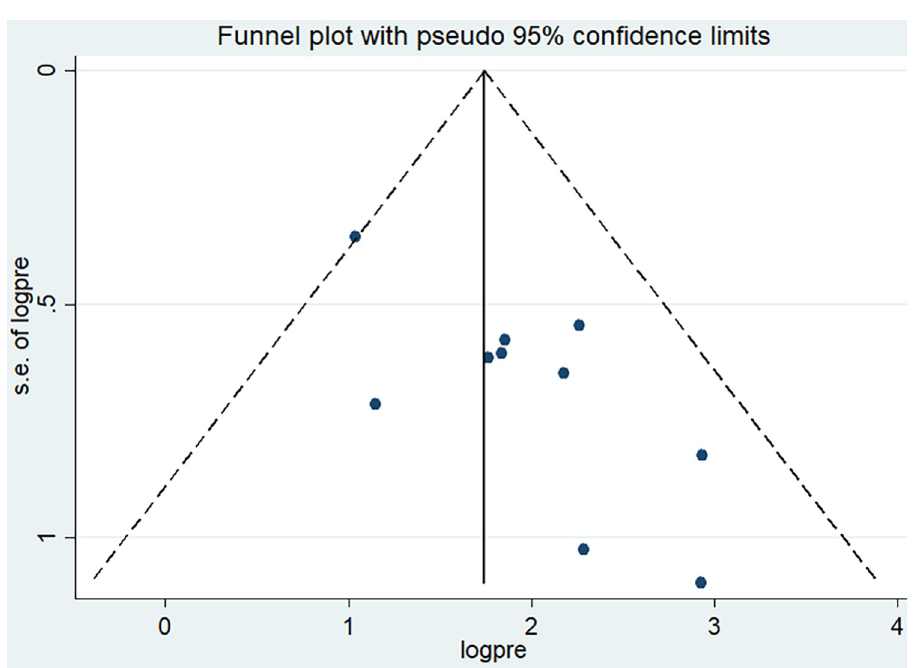
Fig 3. Funnel plot with 95% confidence limit of pooled prevalence of induced abortion among female students in higher education institutions of Ethiopia, 2011 to 2021.